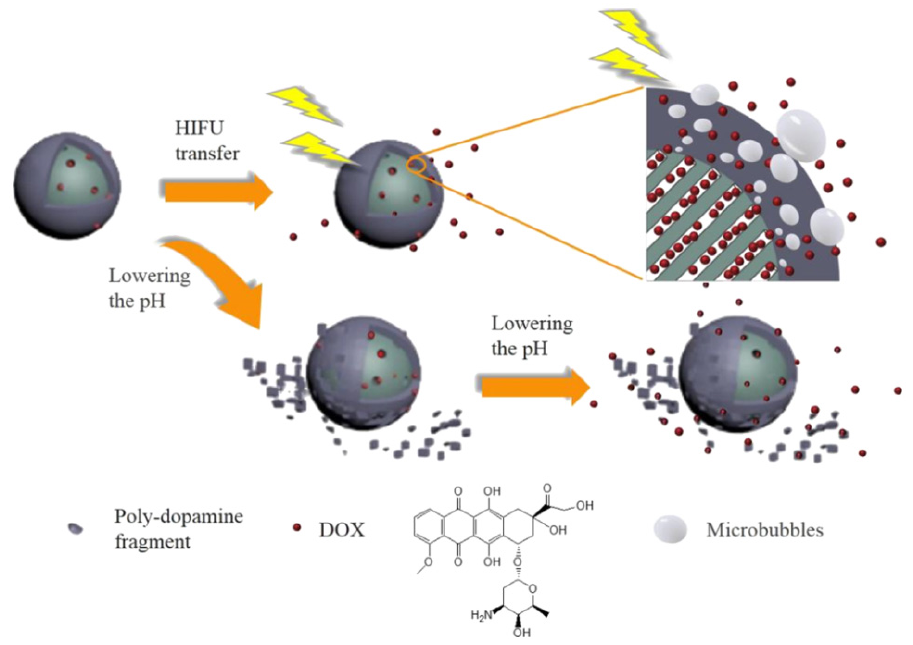
Figure 10. Schematic representation of MSN@DOX − PDA and its pH/HIFU dual-responsive release performances. Reproduced with permission from Ref. [126], Copyright 2021, American Chemical Society.